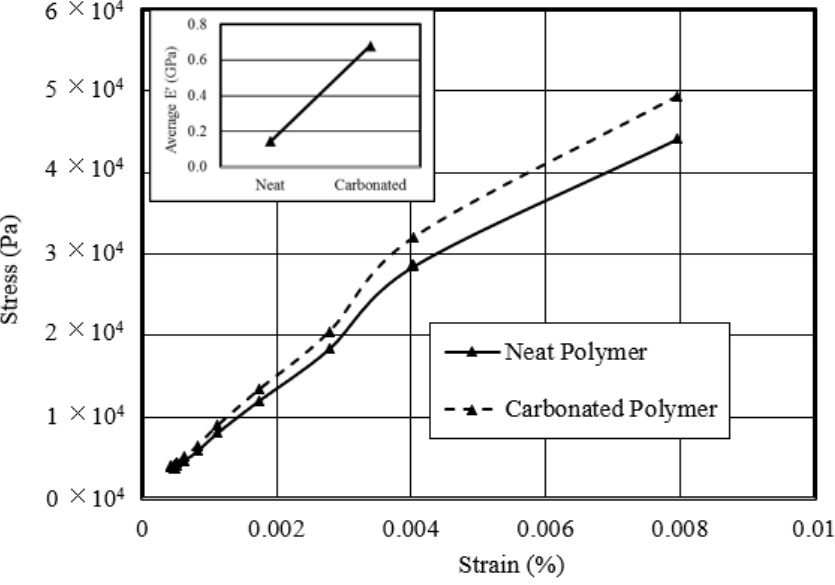
Figure 13. Stress–strain curves of 3D-printed carbonated polymer composite and 3D-printed neat polymer. Inset shows average E’ for neat and carbonated